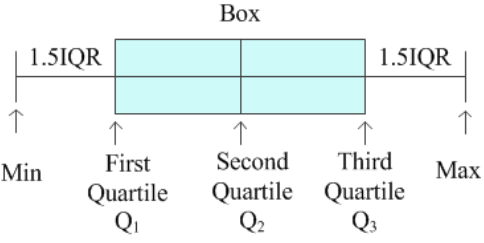
Figure 3. Visual analysis of 20 variables.